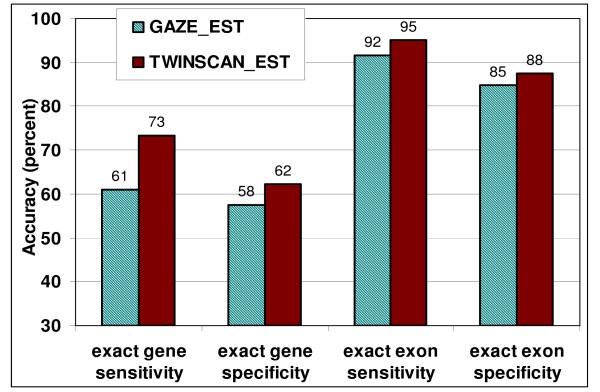
Accuracy on GAZE merged data set. Both GAZE_EST and TWINSCAN_EST used the same BLAT alignments of C. elegans ESTs from dbEST (1/20/2005). Informant database for TWINSCAN_EST is the C. briggsae genome (version cb25.apg8). 305 of the 325 gene loci have at least one EST alignment.